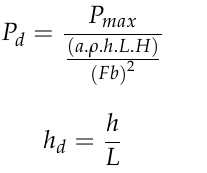
Figure 9. Pressure distribution at the roof of the 755 mm × 300 mm tank, 60° orientation.